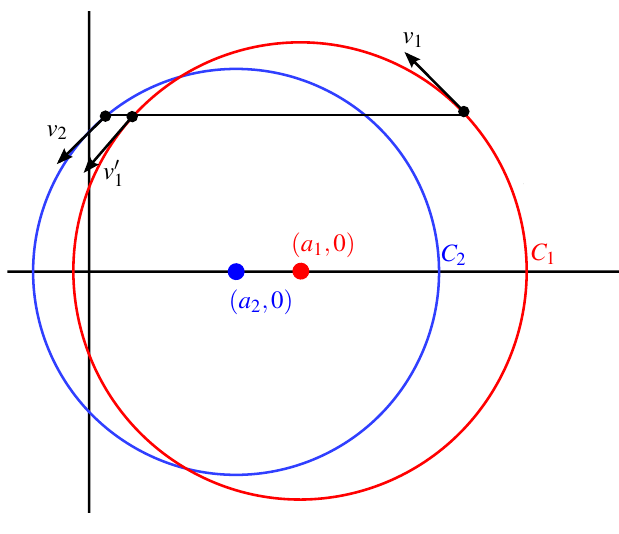
Figure 8: The vectors v 1 and v 2 are admissible with respect to ( x 1 , y ) and ( x 2 , y ) with x 2 ≥ 0 .